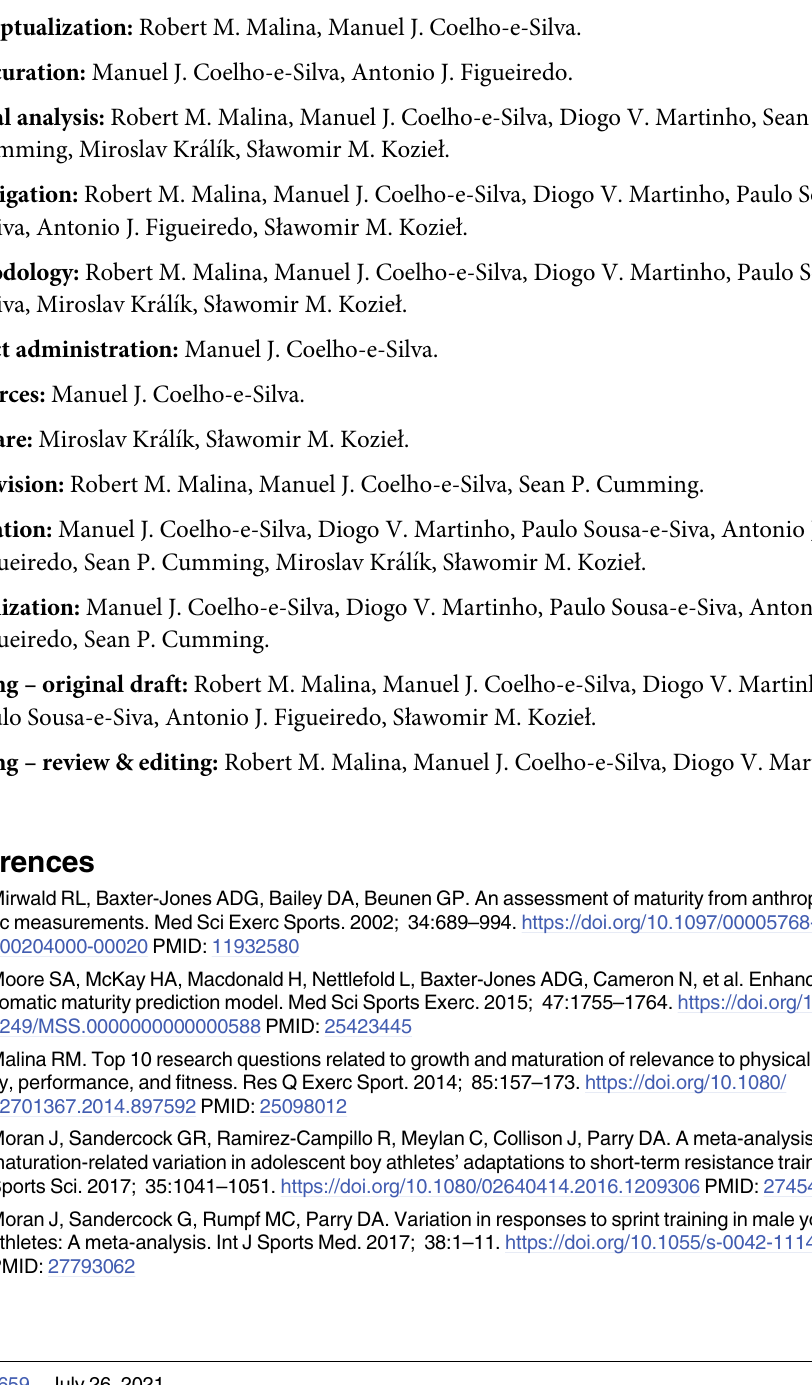
S1 Table. Mixed effects linear models analysis of differences between predicted ages at PHV with the Mirwald (S1A Table) and Moore equations (S1B Table) and observed age at PHV based on the SITAR model, and likelihood ratio tests for differences between two consecutive models (S1C